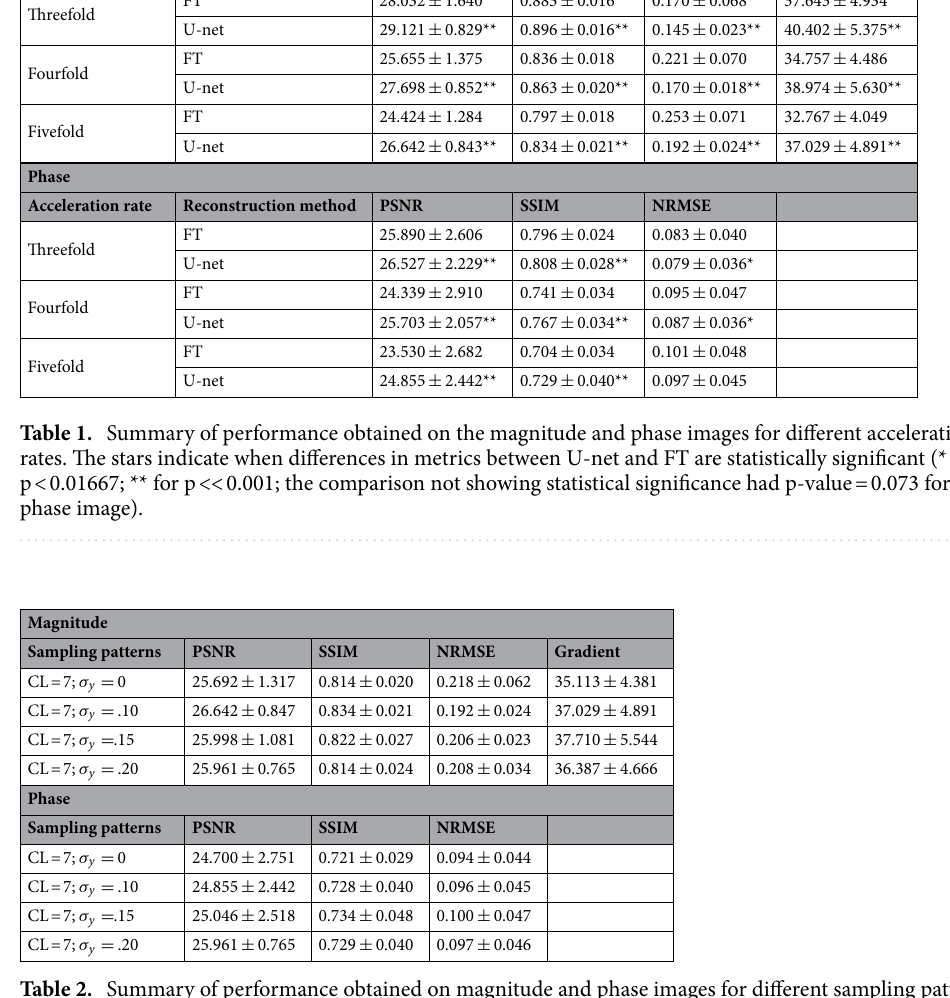
magnitude images are less obvious in phase images. Apart from sampling pattern (a) or σ y = 0 which translated in the lowest performance, the rest of the sam-